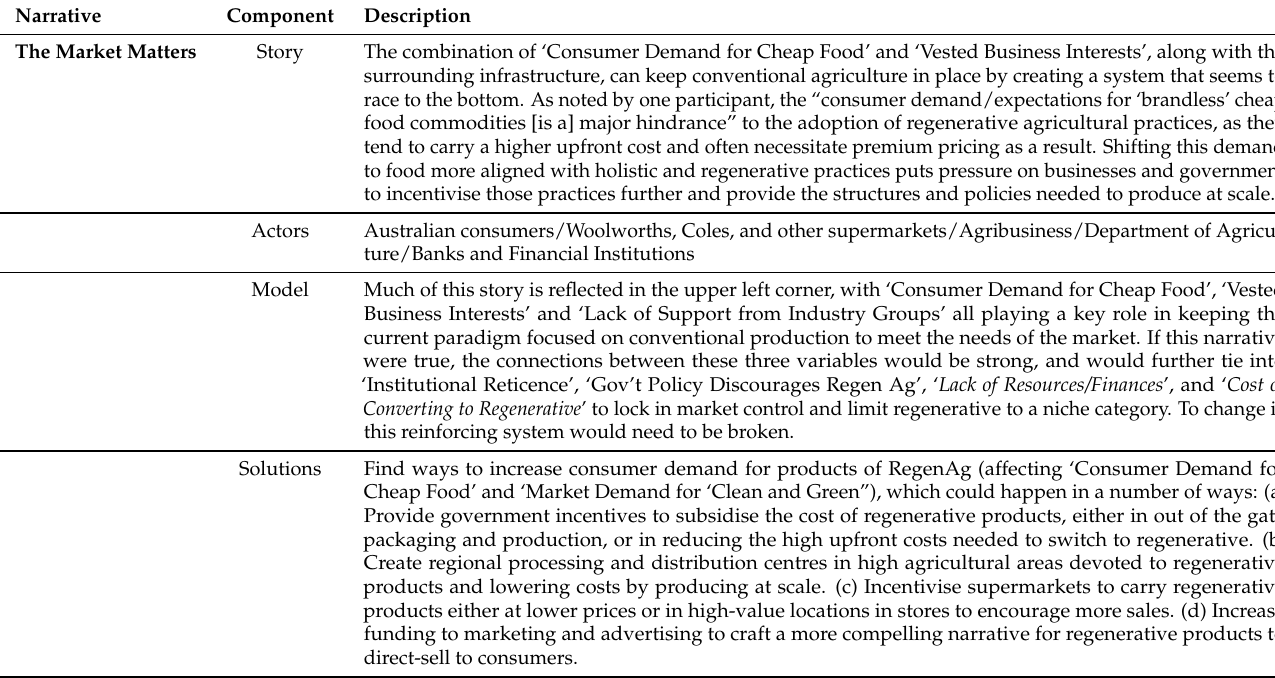
Table 4. Narrative 2: The Market